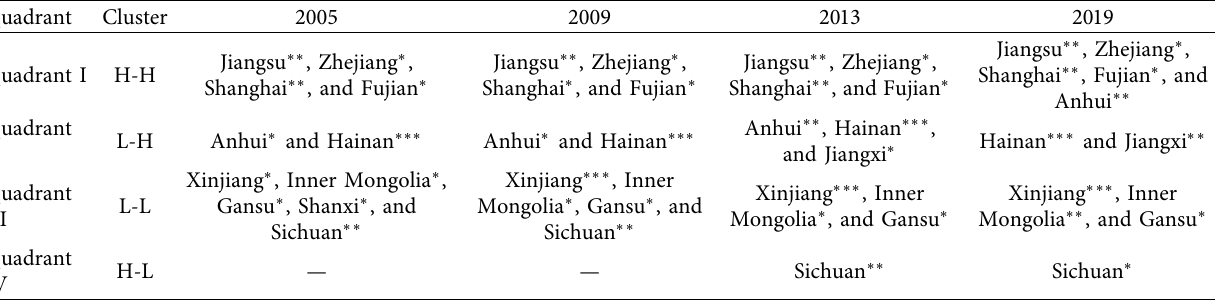
Table 3: Local spatial association pattern classification of